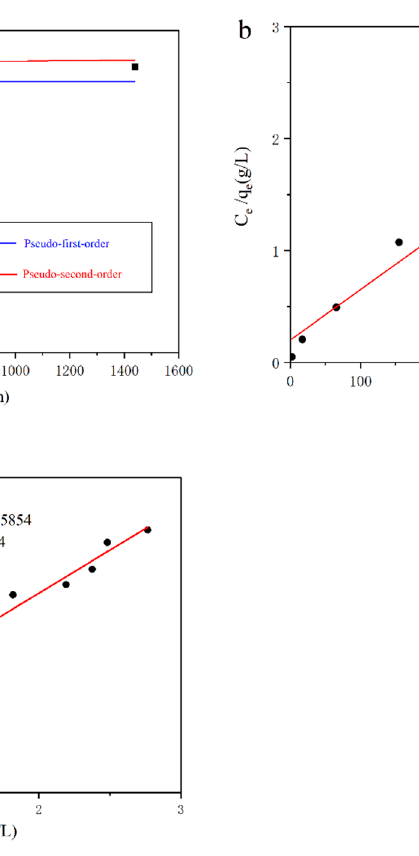
Figure 4. Isotherm and kinetic modeling of the biosorption of Pb(II). ( a ) Biosorption kinetic models; the blue line and red line represent the pseudo-first-order and pseudo-second-order models, respectively. Isotherms of Pb(II) biosorption by PQ7: ( b ) Langmuir; ( c ) Freundlich.